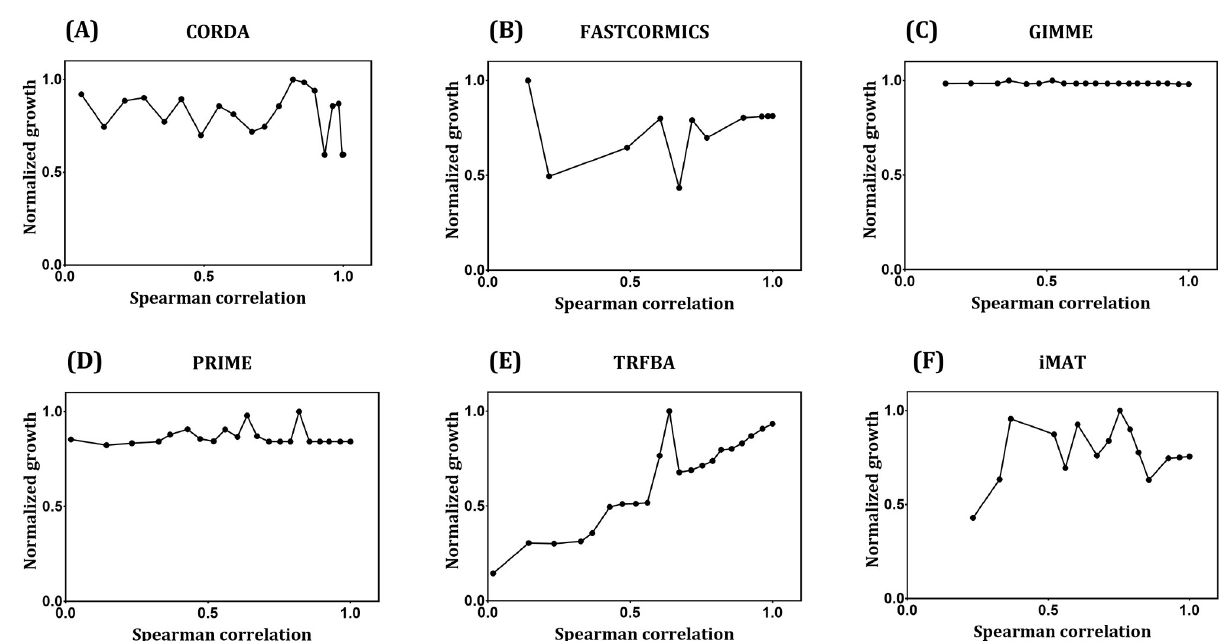
Fig 9. Normalized growth prediction of GEMs generated using noisy expression data. (A) CORDA, (B) FASTCORMICS, (C) GIMME, (D) PRIME, (E) TRFBA, and (F) iMAT. Only GEMs capable of predicting growth are shown. The x-axis shows the spearman correlation coefficient between each set of noisy data and original expression profile ranging from 1 (original) to R < 0.004 (random). For a better comparison, growth rates were normalized to the maximum value.